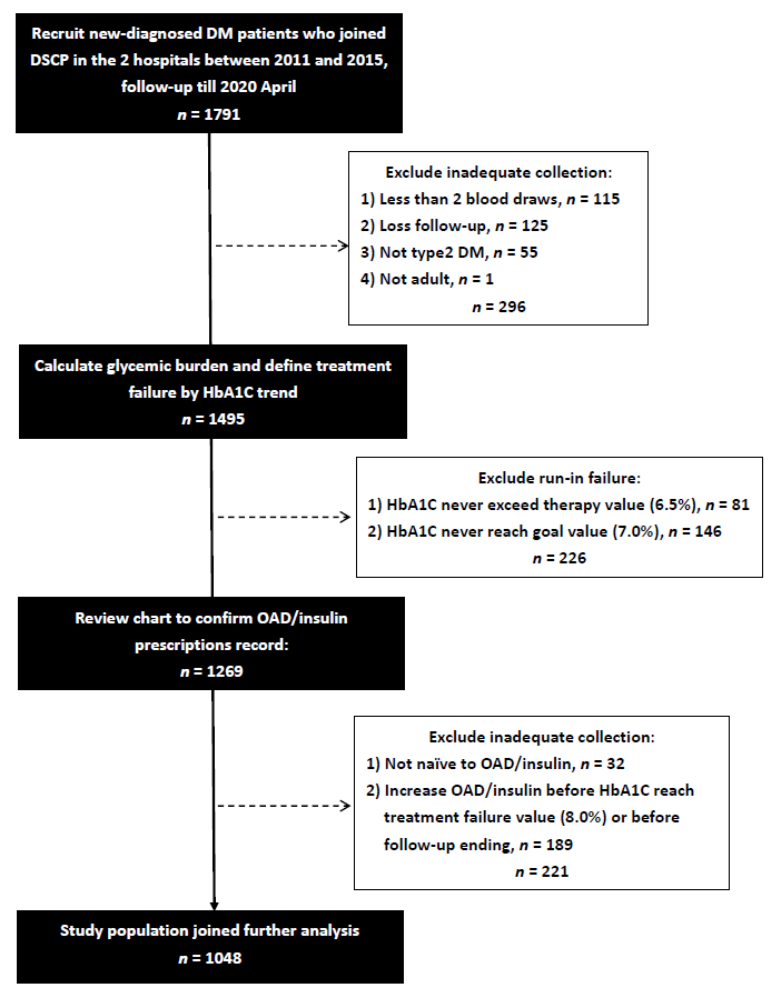
Figure 1. Flow chart of recruited participants.